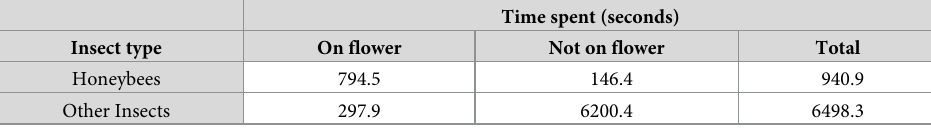
Table 3. Distribution of the durations of time spent within the field of view of the camera for all insects.